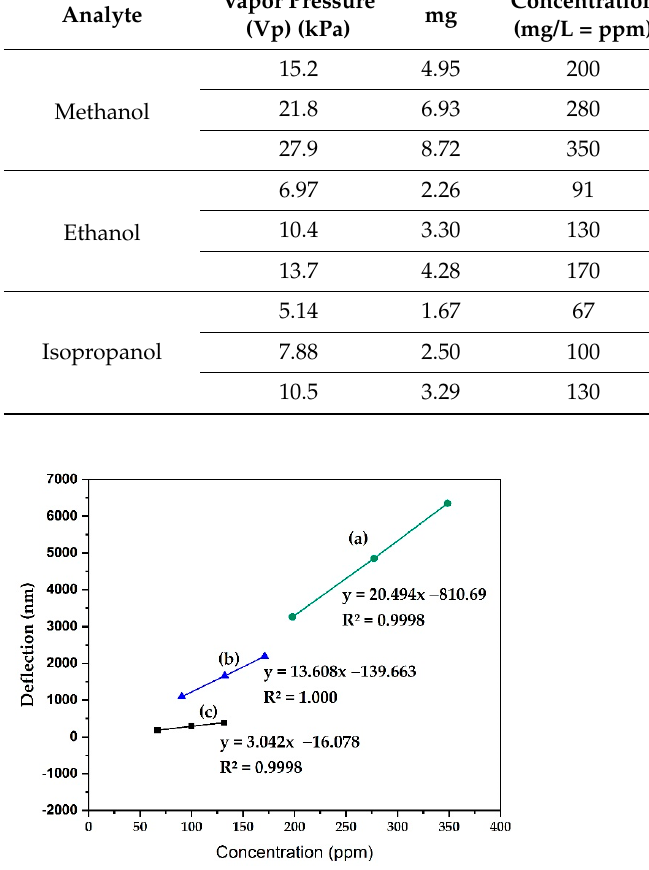
Table 1. Microcantilever deflection values at 580s for the alcohol vapor analytes at the different vapor pressures and corresponding concentrations measured.